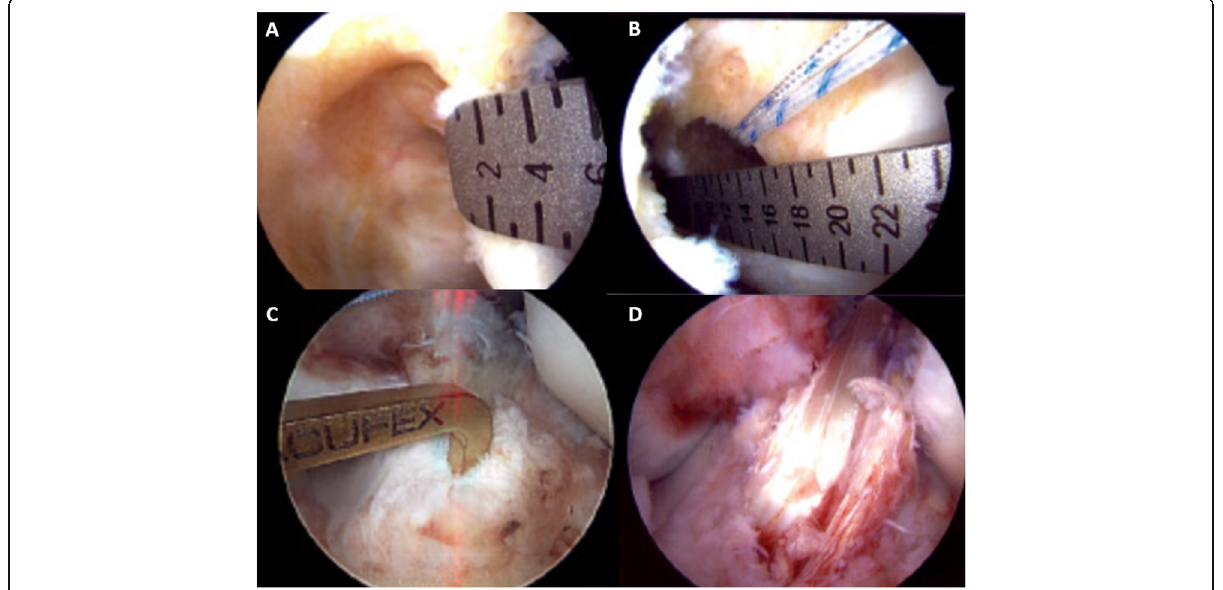
Fig. 5 Anatomic anterior cruciate ligament (ACL) reconstruction on a left knee. a demonstrates 3-4 mm of posterior wall remaining after reaming the femoral tunnel, viewed from the anteromedial portal. b shows the anatomic position of the femoral tunnel viewed from the anteromedial portal, placed within the femoral footprint on the posterior aspect of the condyle. c , viewed from the anterolateral portal, demonstrates the